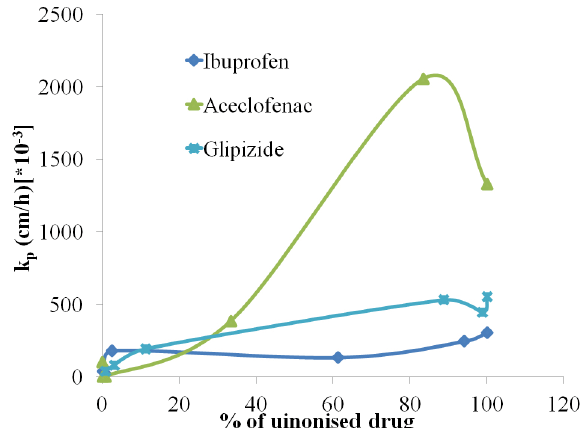
FIGURE 3 - log D vs. Kp of weakly basic drugs.